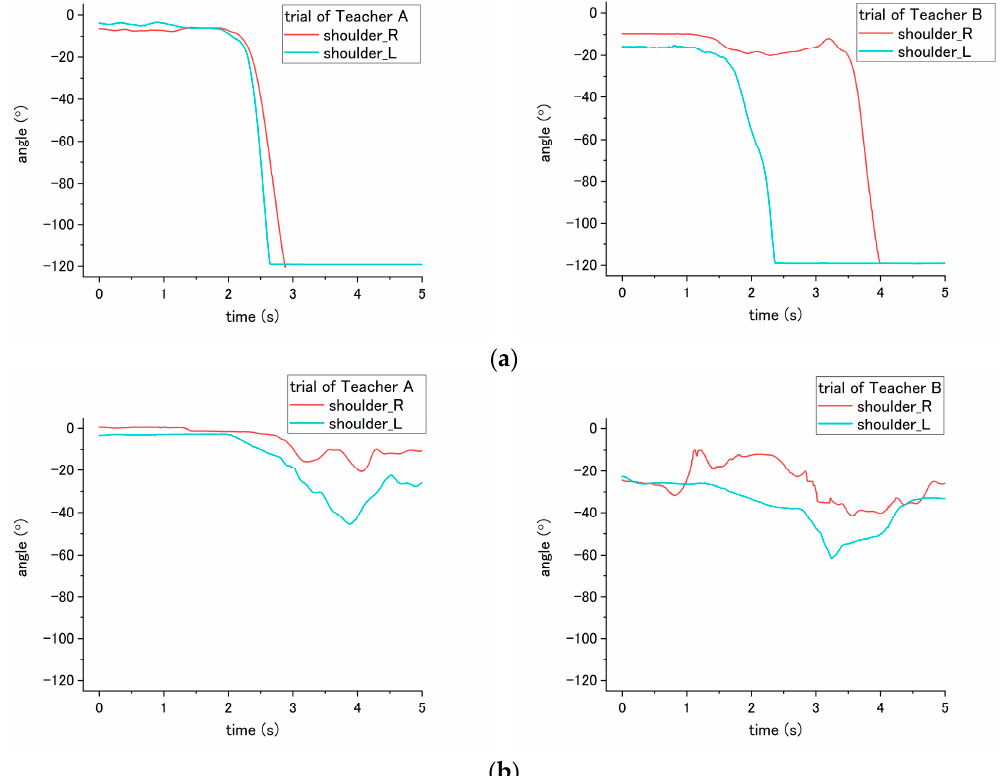
Figure 20. Adduction angle of patient’s shoulder during step No. 7 through the ( a ) correct way, and ( b ) incorrect way conducted at step No. 7.